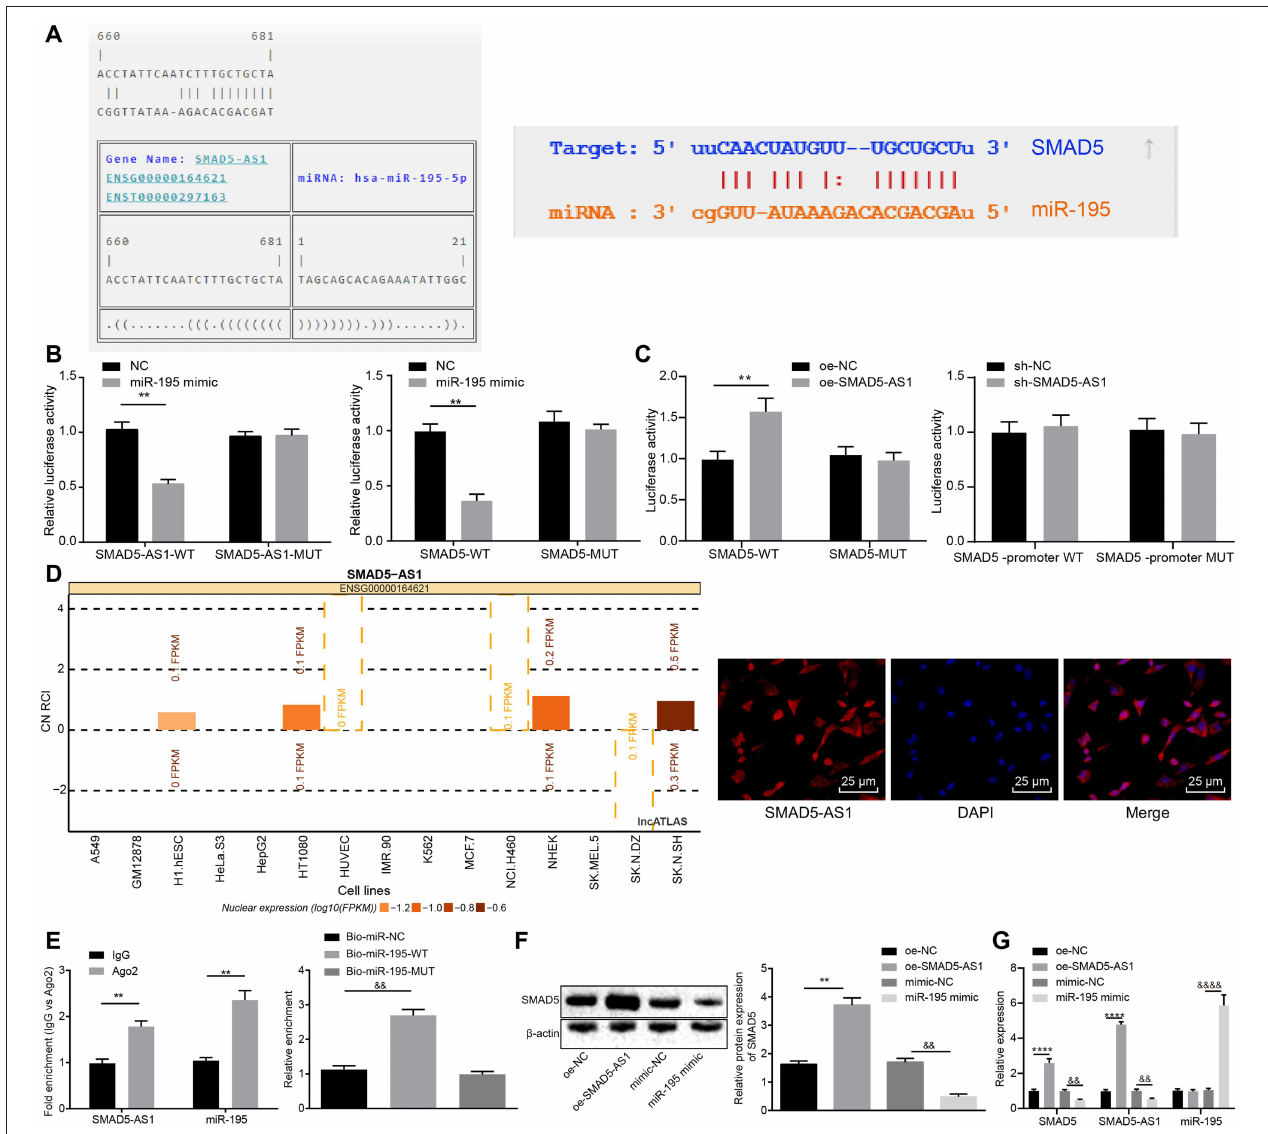
FIGURE 3 | SMAD5-AS1 elevated the expression of SMAD5 by competitively binding to miR-195. (A) The relationship between miR-195 and SMAD5-AS1 analyzed using RNA22 website and that between miR-195 and SMAD5 analyzed using starBase website. In (A) , the sequence of SMAD5 or SMAD5-AS1 is presented on the top in each pair, and that of miR-195 is at the bottom in each pair. (B) The binding of miR-195 to SMAD5-AS1 or SMAD5 in HEK-293T cells verified by dual luciferase reporter gene assay. ** p < 0.01 vs. the NC group. (C) The relationship between SMAD5-AS1 and SMAD5 in HEK-293T cells analyzed by dual luciferase reporter gene assay. ** p < 0.01 vs. the oe-NC group. (D) The subcellular localization of SMAD5AS-1 in CNE-2 cells predicted using the website (http://lncatlas.crg.eu/) and FISH assay (400 × , scale bar = 25 um). (E) Binding of SMAD5-AS1 and miR-195 to AGO2 analyzed by RIP assay, and SMAD5-AS1 enrichment in CNE-2 cells detected by RNA-pull down assay. ** p < 0.01 vs. the IgG group; && p < 0.01 vs. the Bio-miR-NC group. (F) Protein expression of SMAD5 in CNE-2 cells after transfection with oe-SMAD5-AS1 or miR-195 mimic detected by western blot analysis. ** p < 0.01 vs. the oe-NC group; && p < 0.01 vs. the mimic-NC group. (G) Expression of SMAD5-AS1, SMAD5, and miR-195 in CNE-2 cells transfected with oe-SMAD5-AS1 or miR-195 mimic determined by RT-qPCR. ** p < 0.01 vs. the oe-NC group; && p < 0.01 vs. the oe-NC group. &&&& p < 0.01 vs. the mimic-NC group. The data were measurement data, which were expressed as mean ± standard deviation. Independent sample t -test was applied to compare the differences between two groups, and one-way analysis of variance was employed to compare the differences among multiple groups, followed by Tukey’s post-hoc test. The experiment was repeated three times.